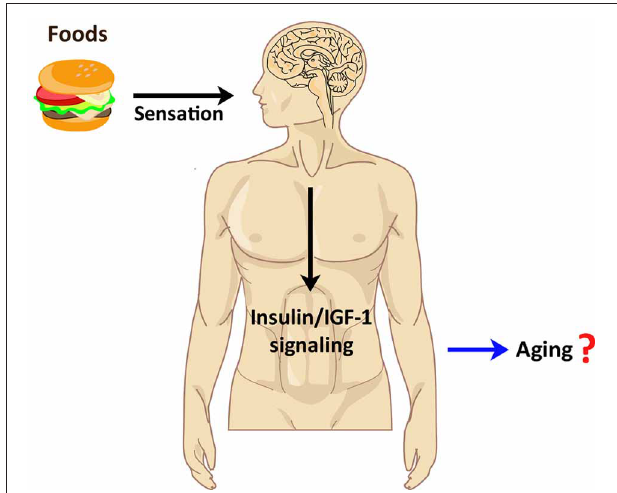
FIGURE 3 | Implication of chemosensory regulation in human aging. Food perception by sensory systems in humans appears to increase human insulin/IGF-1 signaling. Because the insulin/IGF-1 signaling pathway is known to regulate mammalian lifespan, perhaps human chemosensation also influences aging via the insulin/IGF-1